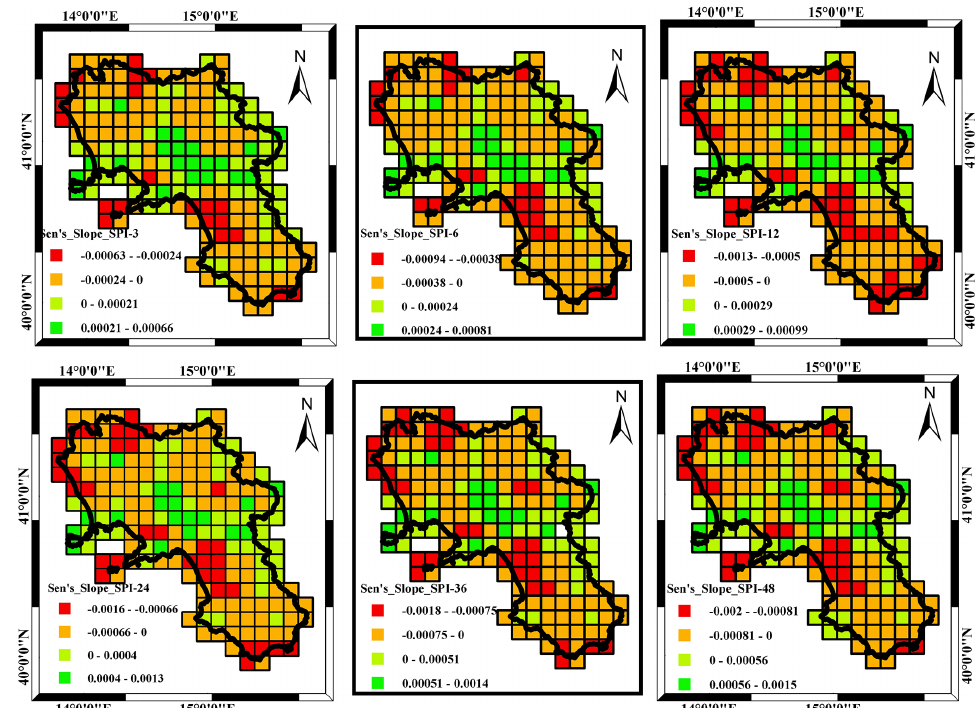
Figure 6. SPI Sen’s slope for the different accumulation